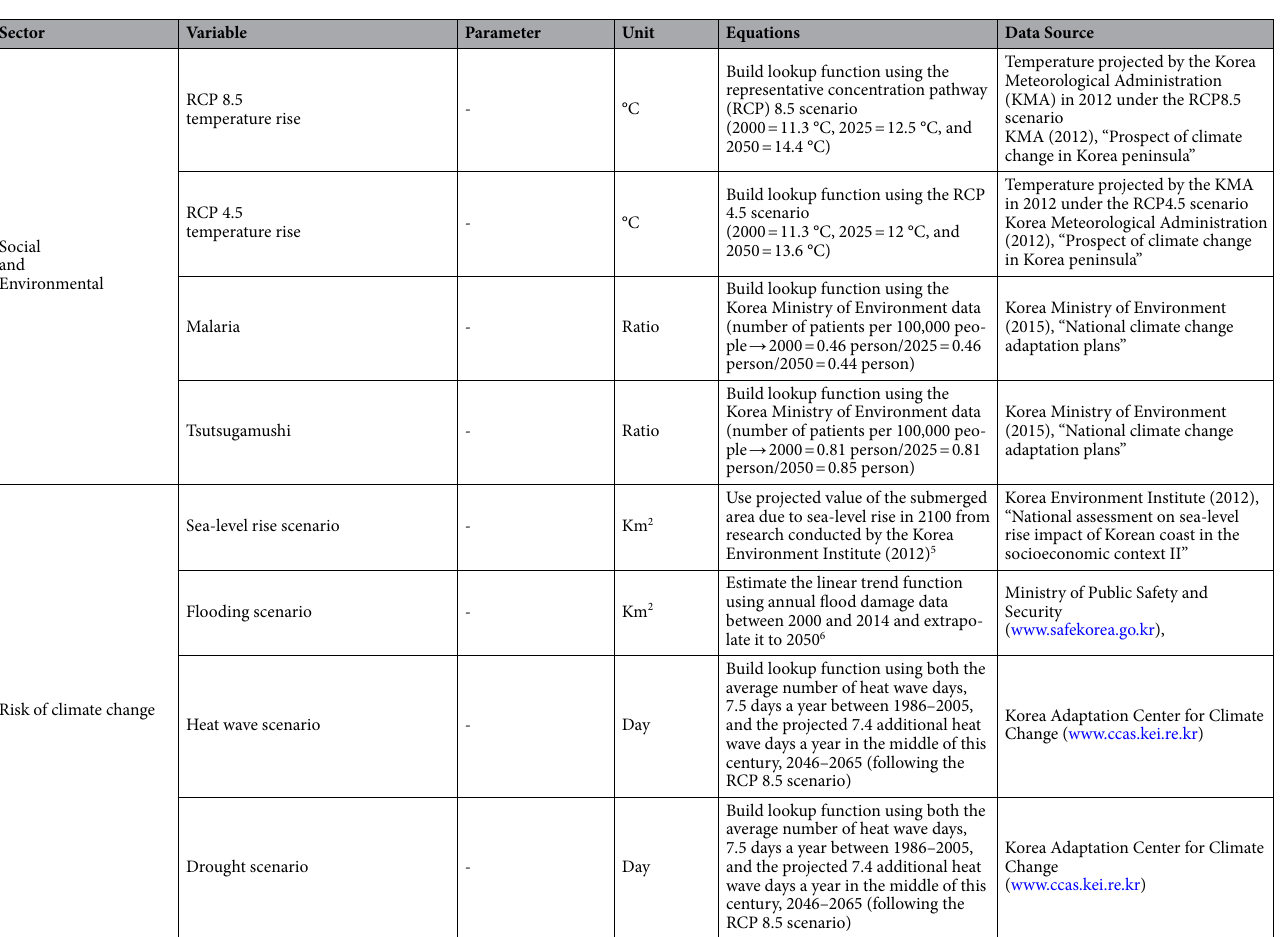
Table 1. Selected model parameters, equations, statistics, and sources. 1 Second new town: Pan’gyo, Dongtan, Gimpo, Paju, Gwanggyo, Yangju, Wi’rye, Godeok, and Gumdan. 2 Flood damage assessment of the urban area: flood damage assessment of buildings, ships, and public facilities. 3 Flood-damaged urban area = flood- damaged area – flood-damaged arable land. 4 Food: grain, vegetable, fruit, and livestock. 5 According to research conducted by the Korea Environment Institute (2012), the area submerged due to the sea-level rise in 2100 was projected as 3,733 km 2 , and the annual submerged area was calculated by evenly distributing the projected submerged area to years 2006 to 2100. Using this projected value and process, the annual submerged area was calculated by evenly distributing the projected value to years 2000 to 2100 and applying this value to the simulation period, 2000 to 2050. 6 The estimated linear trend function was Y = 0.6588X-0.34, and